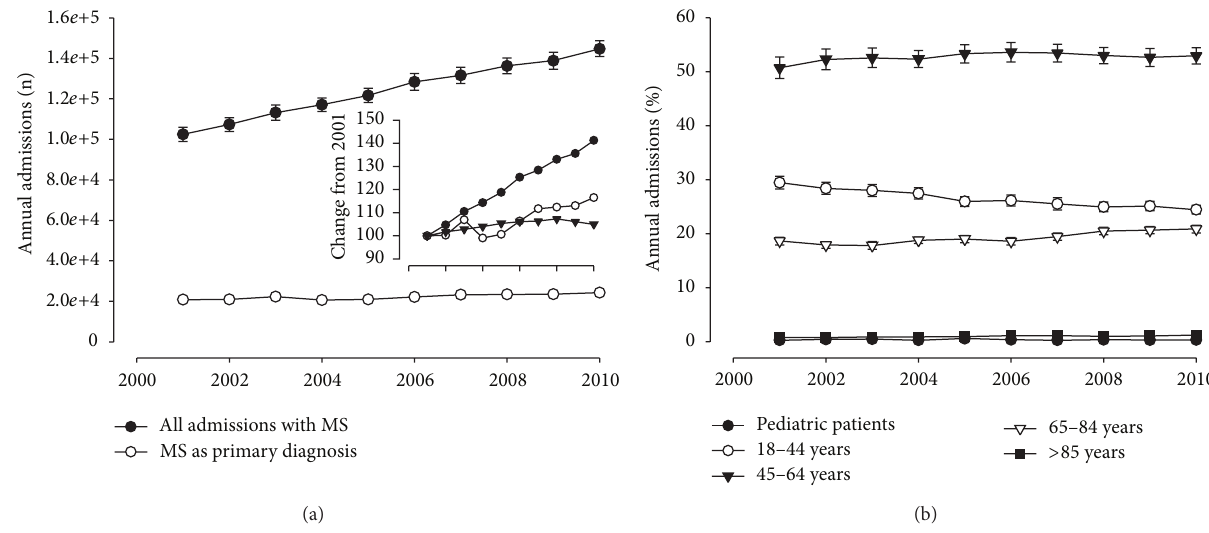
Figure 1: (a) Annual admissions for MS for the decade between 2001 and 2010 separated for MS as primary diagnosis (white circles) of all admissions that included MS as a diagnosis (black circles); the insert shows percentage of change from baseline in 2001 in comparison to all hospitalizations (triangles). (b) Relative age distribution of MS-related admissions during the 10-year period based on predefined age